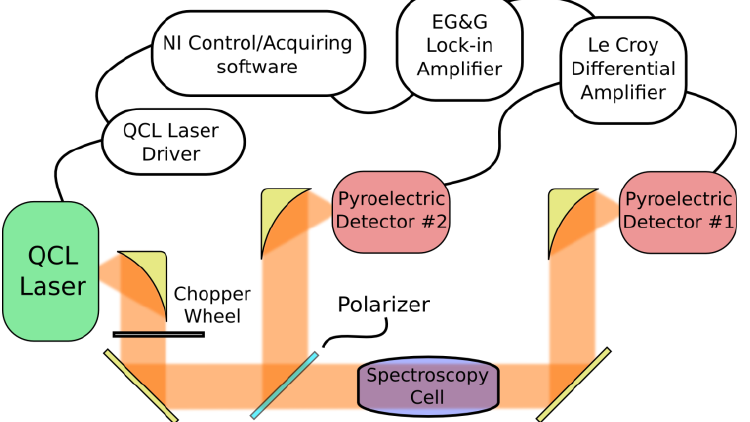
Figure 1. Experiment apparatus used for high sensitivity spectroscopy. The THz QCL laser is housed in a closed-cycle Stirling Cryostat, so that it can be operated at room temperature. Therefore the whole set-up has been mounted on a compact and transportable breadboard, allowing in situ measurements (spectrometer overall dimensions: 90 × 60 × 90 cm, total weight: <100